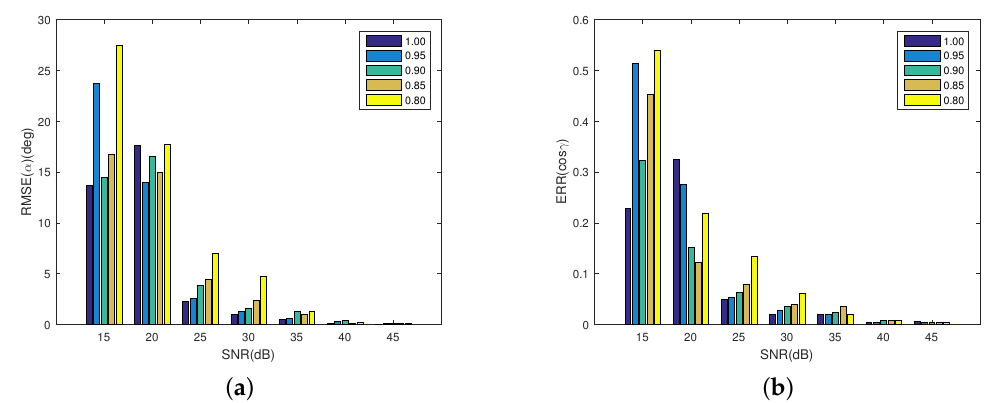
Figure 15. Estimating error of precession angle and observing angles. ( a ) shows the estimating error of the precession angle; and ( b ) depicts the estimating error of the observing angles. Different colors denote different fill